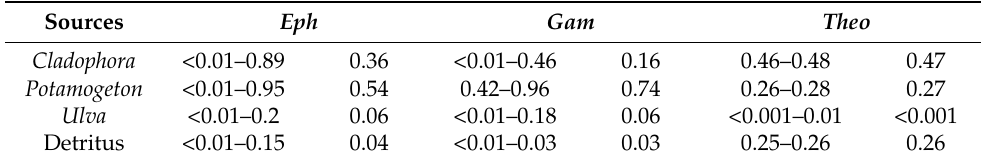
Figure 5. Stable isotopes signatures (‰) of various forms of macrophytes, algae-derived detritus and their potential grazers at site 2 (triangle) and site 4 (dots). Full data are given in Table 2. Green markers showed signatures of sources and black ones for consumers. Abbreviations: Pot.— Potamogeton , Clad.— Cladophora , Gam.— Gammarus , Chir.—Chironomidae, Hept. – Heptagenia . Erp.— Erpobdella . Table 3. Predicted 2.5–97.5% quantiles and proportion mean ± 1SD values of coastal produc- ers’ contributions to the diet of primary consumers and omnivores from the second trophic level (ephemeropteran Heptagenia sulphurea ( Eph ), amphipod Gammarus tigrinus ( Gam ) and gastropod Theo- doxus fluviatilis ( Theo ) at site 2 based on Bayesian mixing model performed with MixSIAR package in